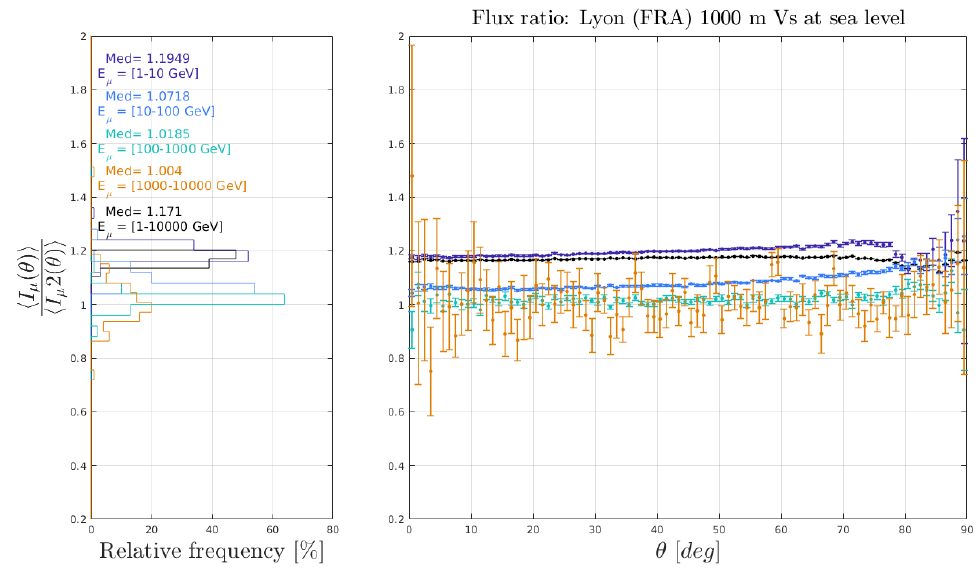
Figure 8. ( Left panel ) Histogram of flux ratio values computed over the zenith angle range (details are shown in the right figure) for several energy ranges from 1 to 10 4 GeV (in color) and for the whole energy range (in black). ( Right panel ) Flux ratio as function of the zenith angle θ in Lyon, France at (1) 1000 m of elevation and at (2) sea level, for the same energy ranges as the left panel. The second is the reference flux (ratio denominator). Same atmosphere and magnetic field for both fluxes were considered. Med corresponds to the median value in each energy